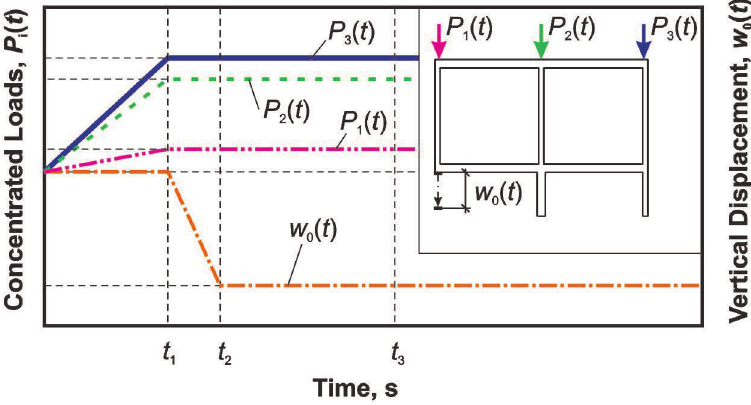
Figure 14. The loading process within the framework of the numerical simulation.